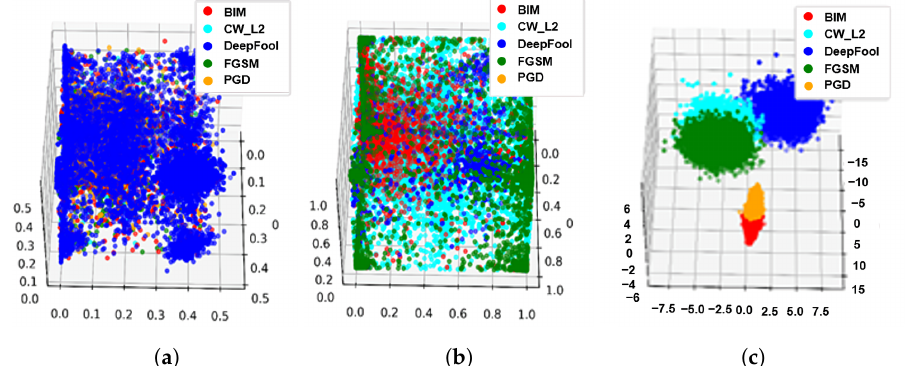
Figure 6. Visualized clustering results of the proposed method under the MNIST dataset. ( a ) Ad- versarial example + k-means (Step3). ( b ) Adversarial perturbation + k-means (Step 1 + Step 3). ( c )